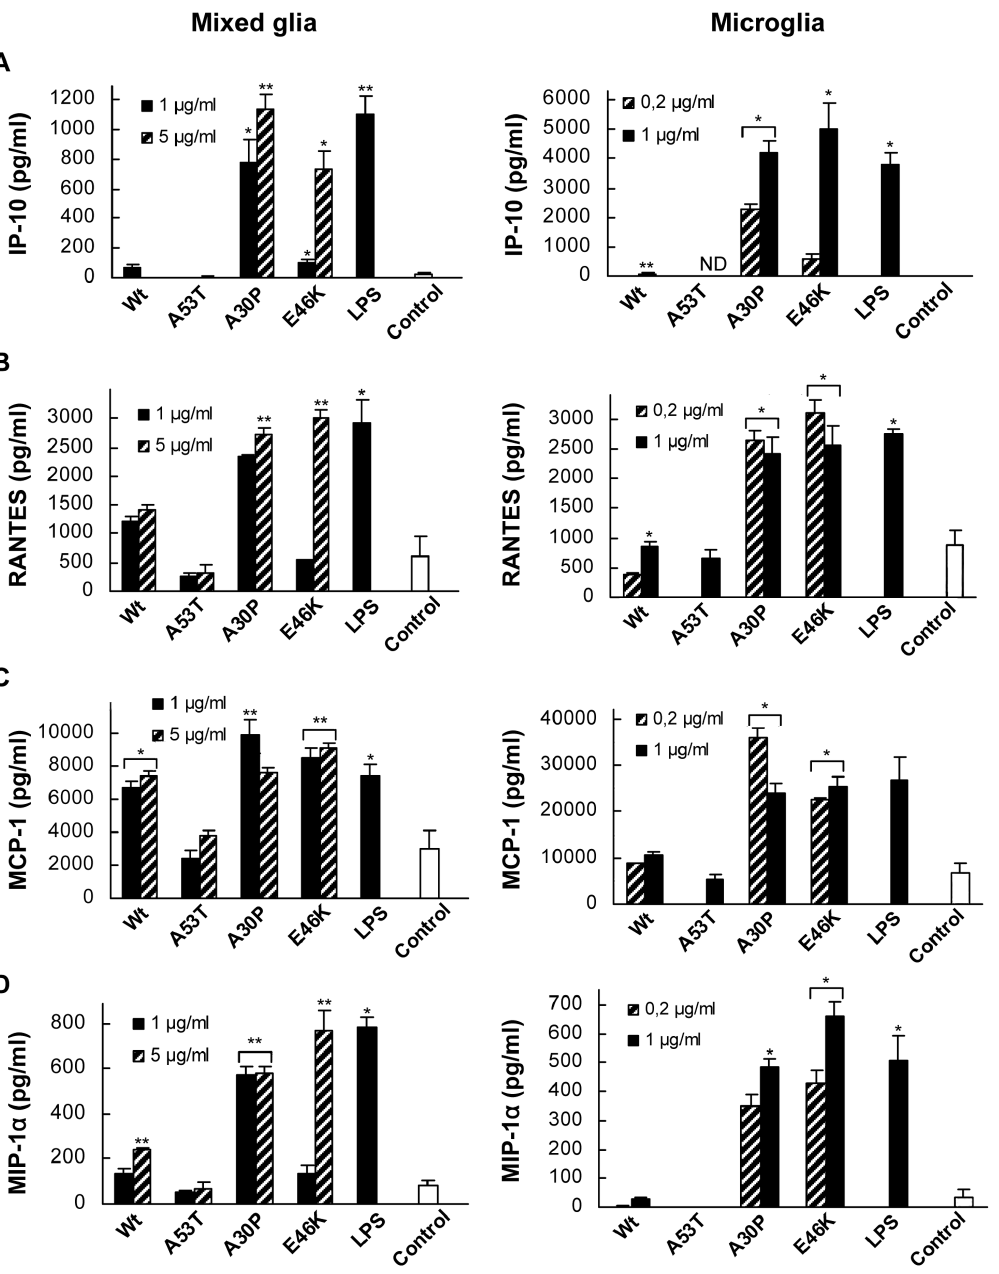
Figure 5. Chemokine release profile of a -Syn-stimulated primary mixed glial cultures and isolated microglia cultures. IP-10 ( A ), RANTES ( B ), MCP-1 ( C ), and MIP-1 a ( D ) were measured in supernantants of mixed-glial cultures (left) and microglia (right) after a 20-hour treatment with monomeric Wt or mutant a -Syn variants, or lipopolysaccharide (LPS). All chemokines were assayed by ELISA as described in Materials and Methods. Values are mean 6 S.E.M. (n=2). * P , 0.05, ** P , 0.01. The results shown are representative of two and three independent experiments with microglia and mixed glial cultures, respectively.